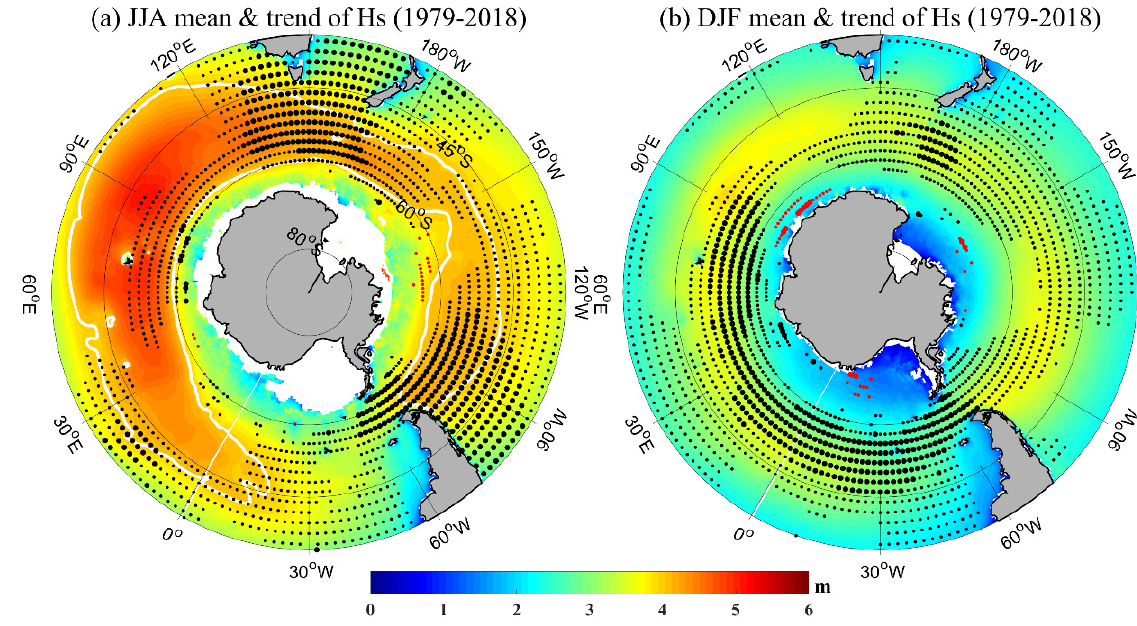
Figure 2. Mean SWH and trend during 1979–2018: ( a ) in winter (JJA), ( b ) in summer (DJF). The white contours are the 4 m isoline. The small black dots indicate where the trend was higher than 0.004 m/a and less than 0.008 m/a, the larger black dots show where the trend was larger than 0.008 m/a, and the red dots indicate a decreasing trend with the criteria similar to those of the black dots.